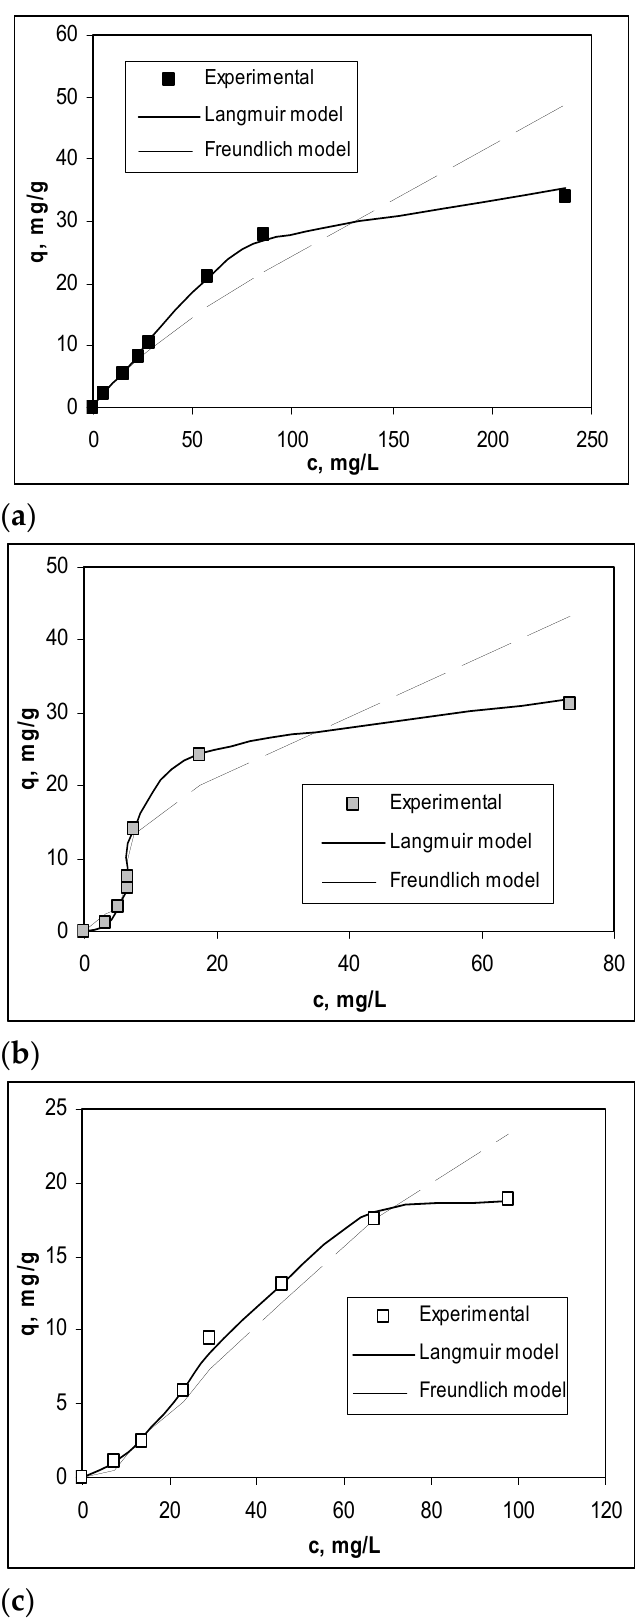
Figure 4. Experimental and modeled isotherms obtained for the biosorption of Pb(II) ( a ), Cd(II) ( b ), and Zn(II) ( c ) on Na-SW biosorbent.